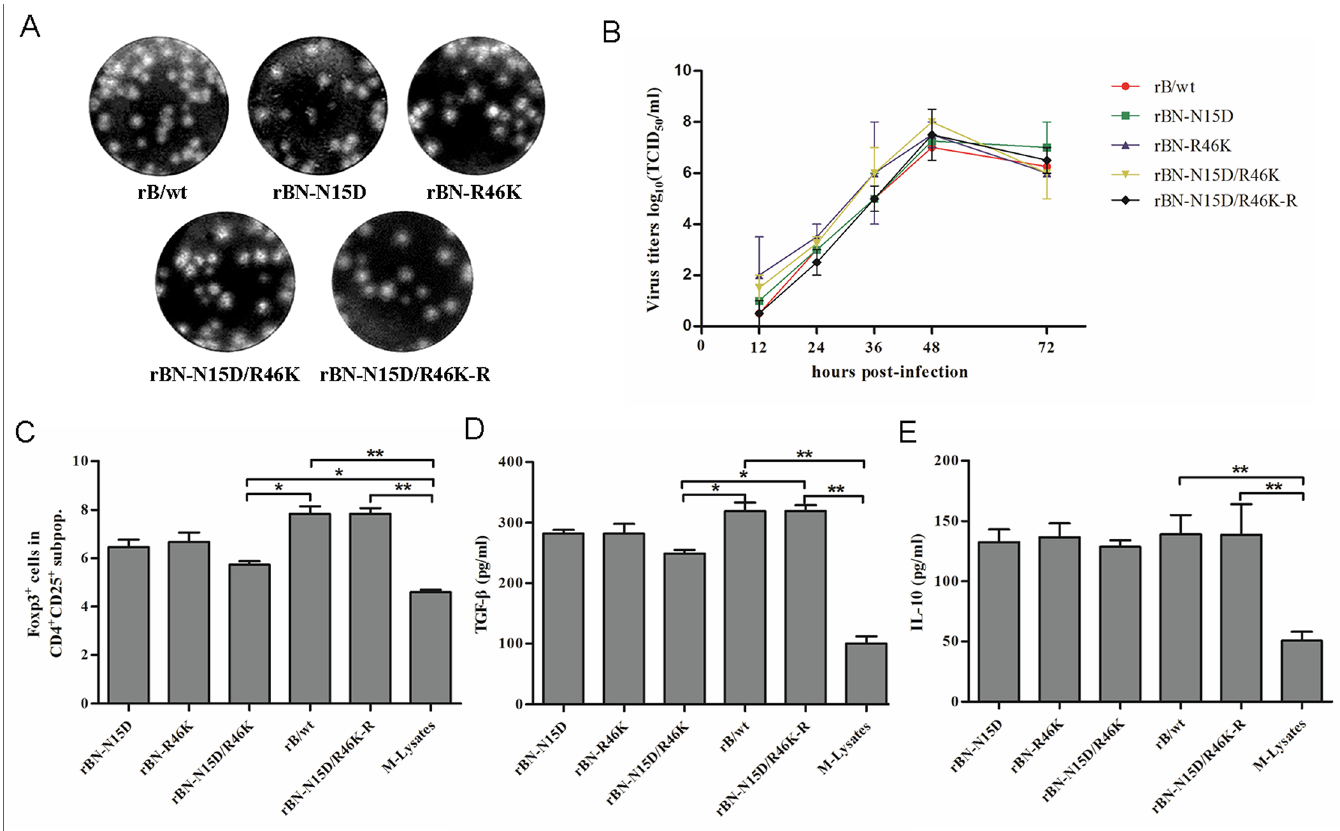
Fig 7. Effects of the mutant recombinant PRRSV strains on Tregs induction. (A) Plaque morphology assay of the recombinant mutant strains. (B) Growth kinetics of the recombinant mutant strains. (C) Percentage of Foxp3 + cells in the gated CD4 + CD25 + subpopulations of the recombinant viruses. (D) Concentrations of TGF- β in the supernatants of 3-day co-cultures. (E) Concentrations of IL-10 in the supernatants of 3-day co-cultures. All data are represented as the means ± standard deviation of three independent experiments, and data analysis was done using one-way ANOVA and significant differences are shown ( * P < 0.05 and ** P <